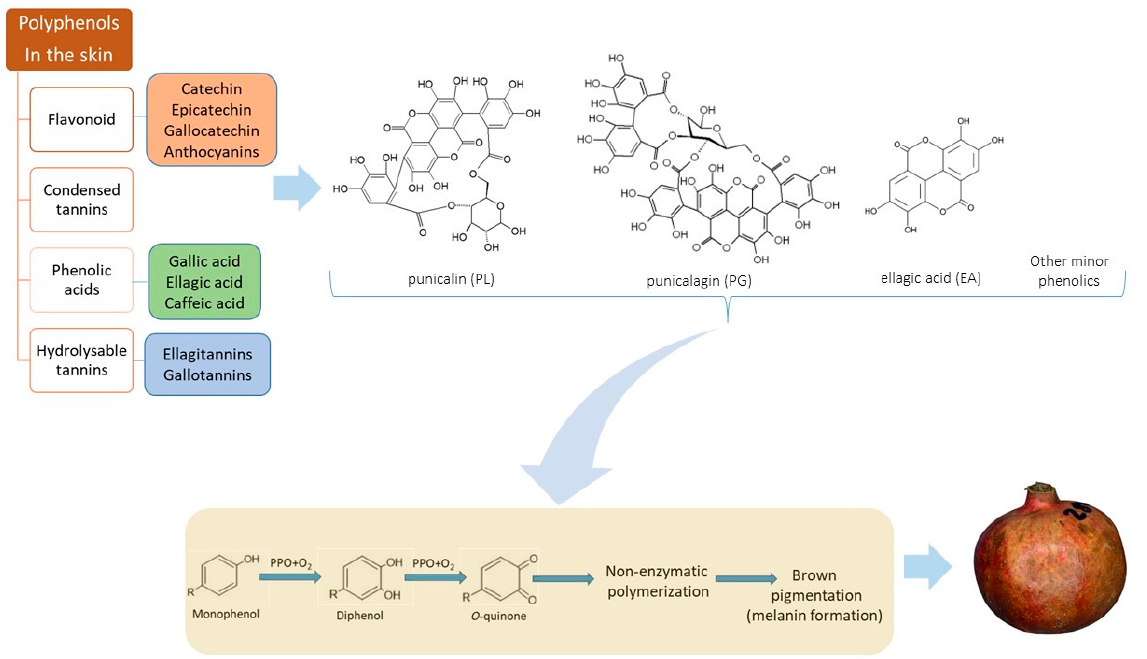
Figure 2. Pomegranate polyphenols in the skin, chemical structures of punicalin (PL), punicalagin (PG) and ellagic acid (EA), and brown pigment (melanin) formation from phenolic compounds [29– 31].